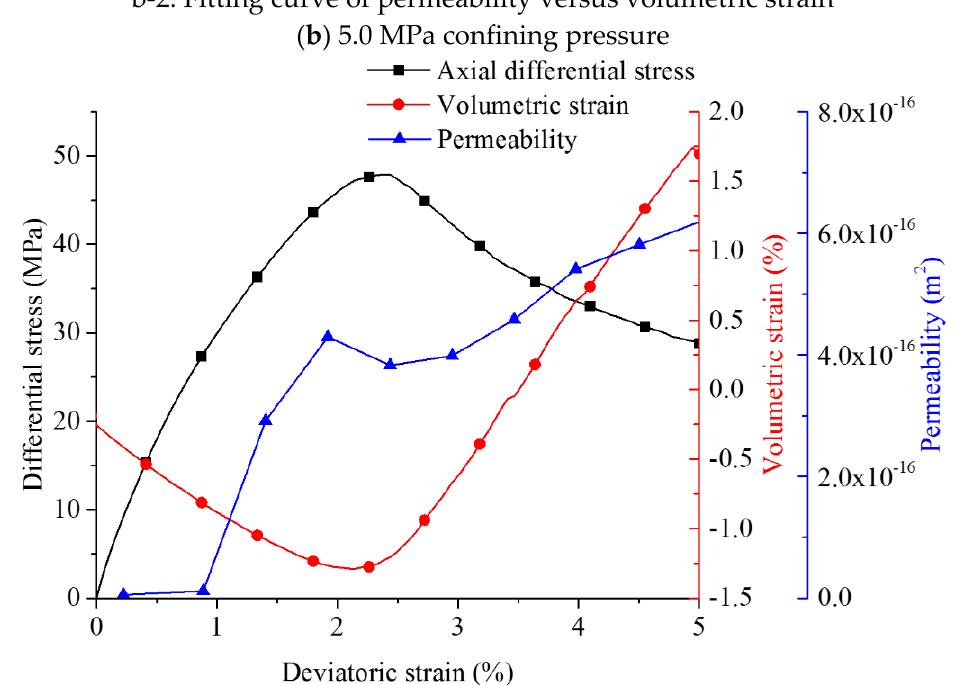
b-2: Fitting curve of permeability versus volumetric strain